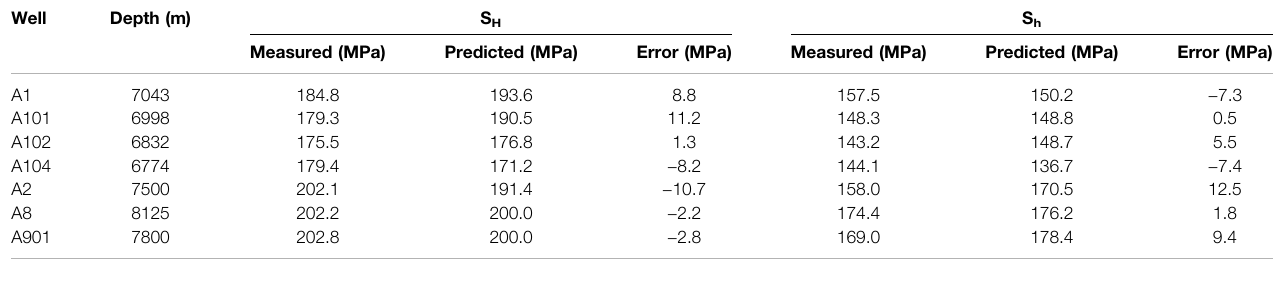
TABLE 1 | Analysis of numerical simulation results of in situ